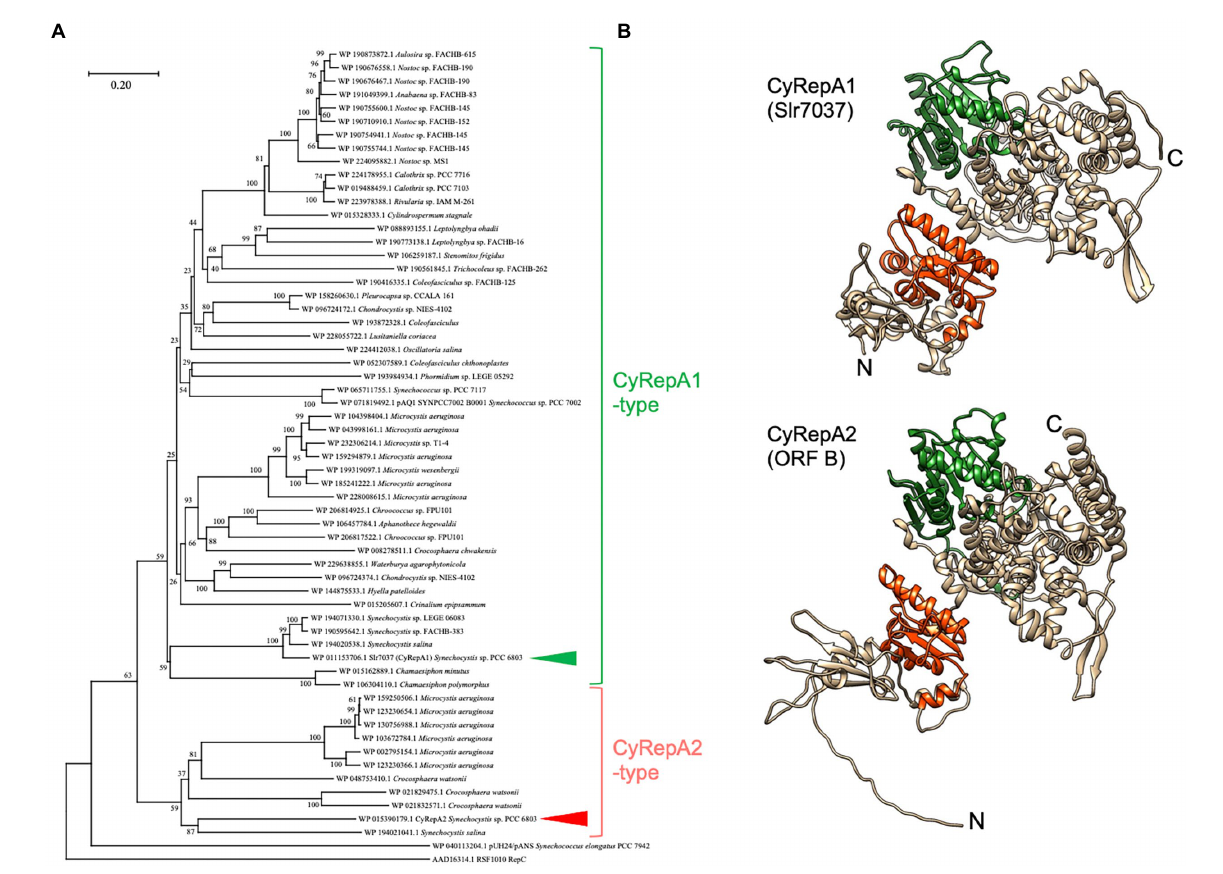
FIGURE 1 Phylogenetic and structural analysis of Cyanobacterial Rep protein A (CyRepA1: Slr7037; CyRepA2: ORF B). (A) Phylogenetic tree of CyRepA. CyRepA2 (ORF B) and its 58 homologs were used for phylogenetic analysis along with pUH24/pANS Rep and RSF1010 RepC used as outgroups. Proteins used for analysis were shown by their accession numbers in database with organism names. The tree is drawn to scale, with branch lengths in the same units as those of the evolutionary distances used to infer the phylogenetic tree. CyRepA1 (Slr7037) and CyRepA2 are indicated by arrow heads. (B) 3D structures of CyRepA1 and CyRepA2 predicted using AlphaFold2. The 3D structures are color-coded as follows based on the results of domain predictions by SMART and Pfam. DUF3854 domain (orange), DEXDc domain